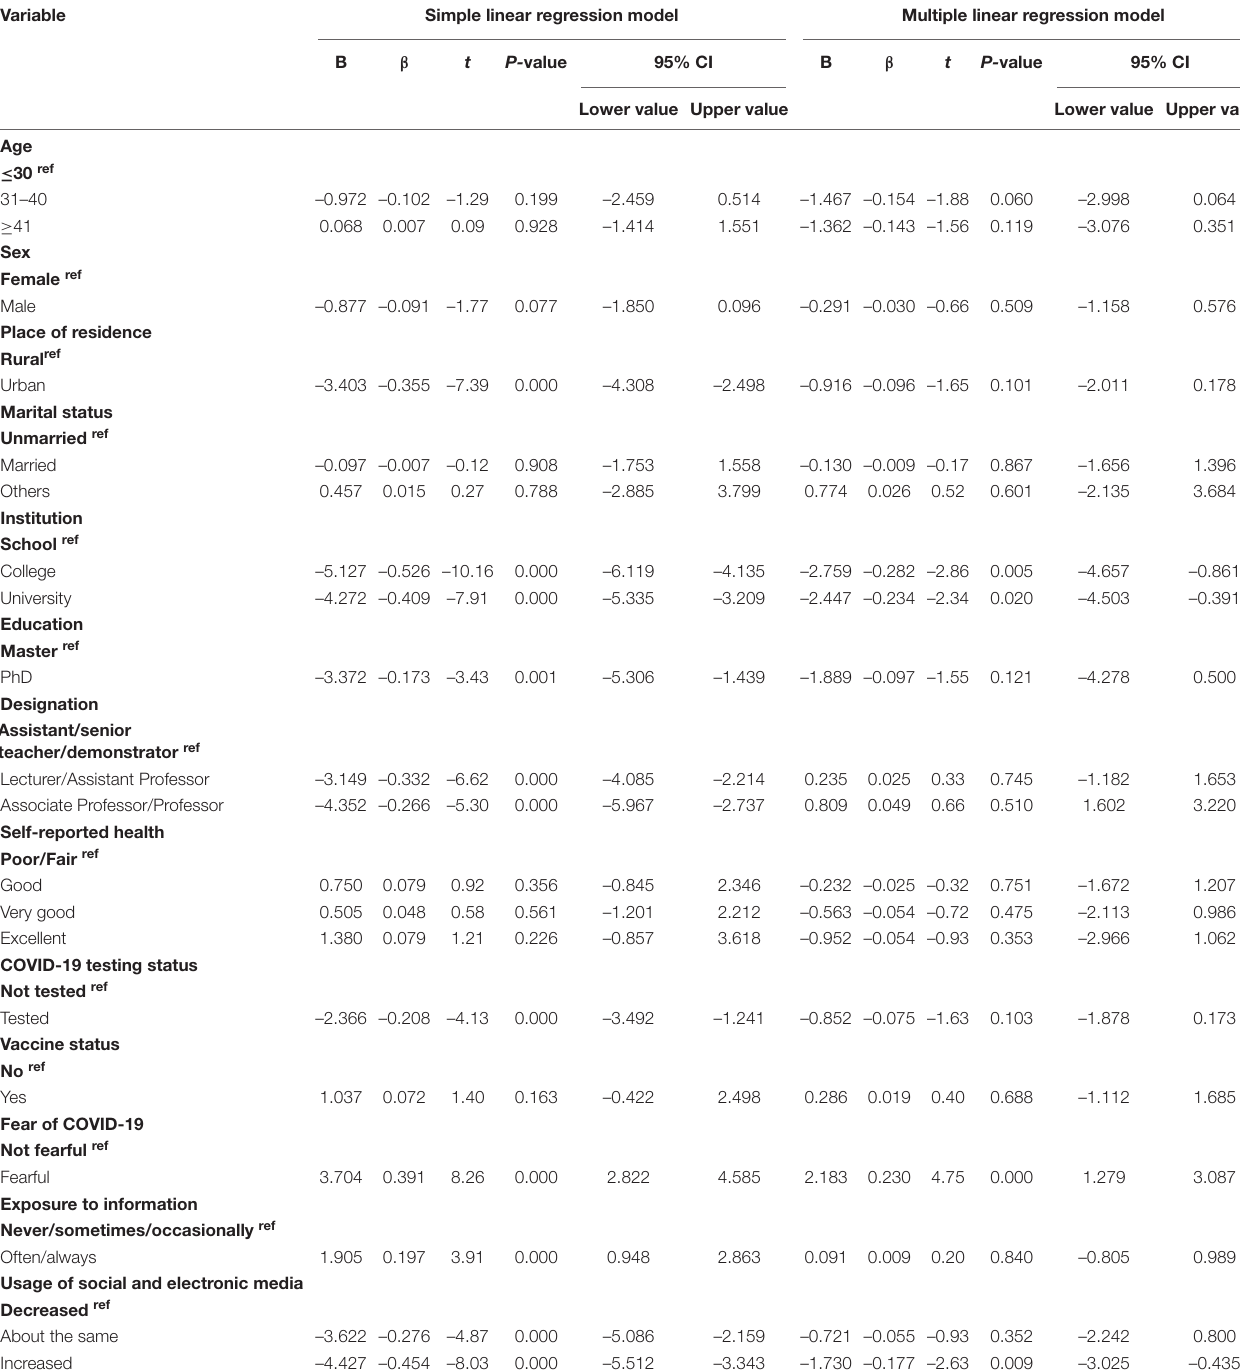
B Unstandardized Coefficient, β Standardized Coefficient, CI Confidence interval, and ref Reference